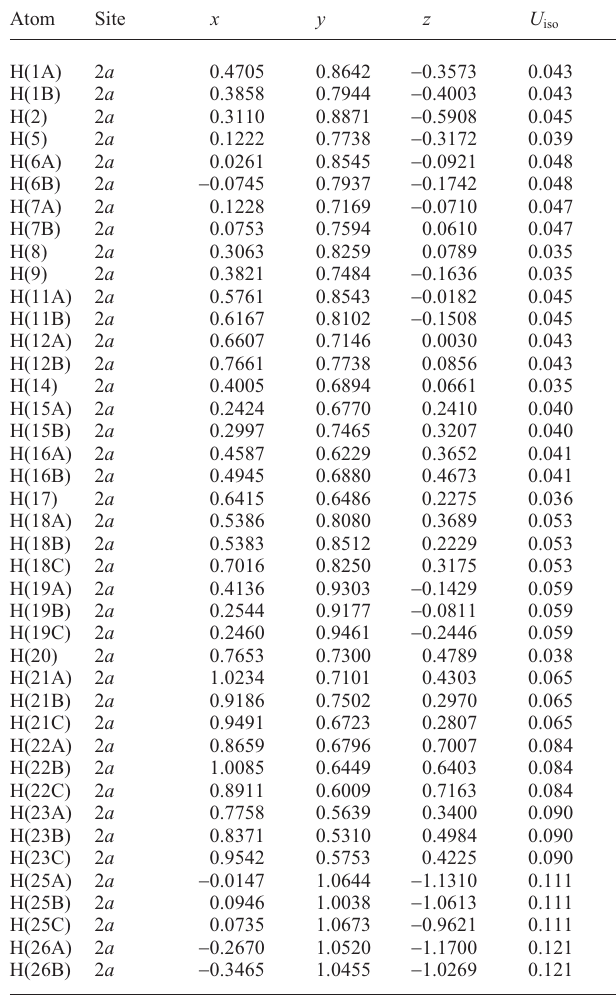
Table 2. Atomic coordinates and displacement parameters (in Å 2 )